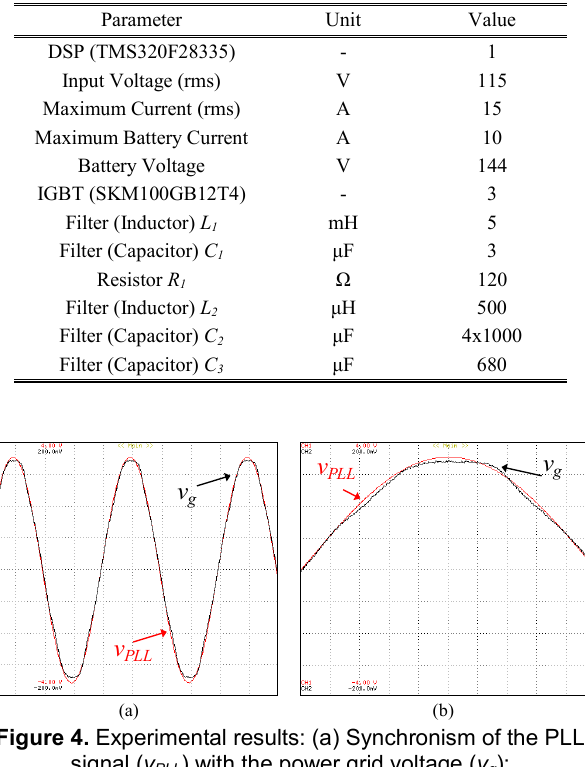
Figure 3. Laboratory workbench used for the experimental tests. Table 1. Specifications of the Developed System.